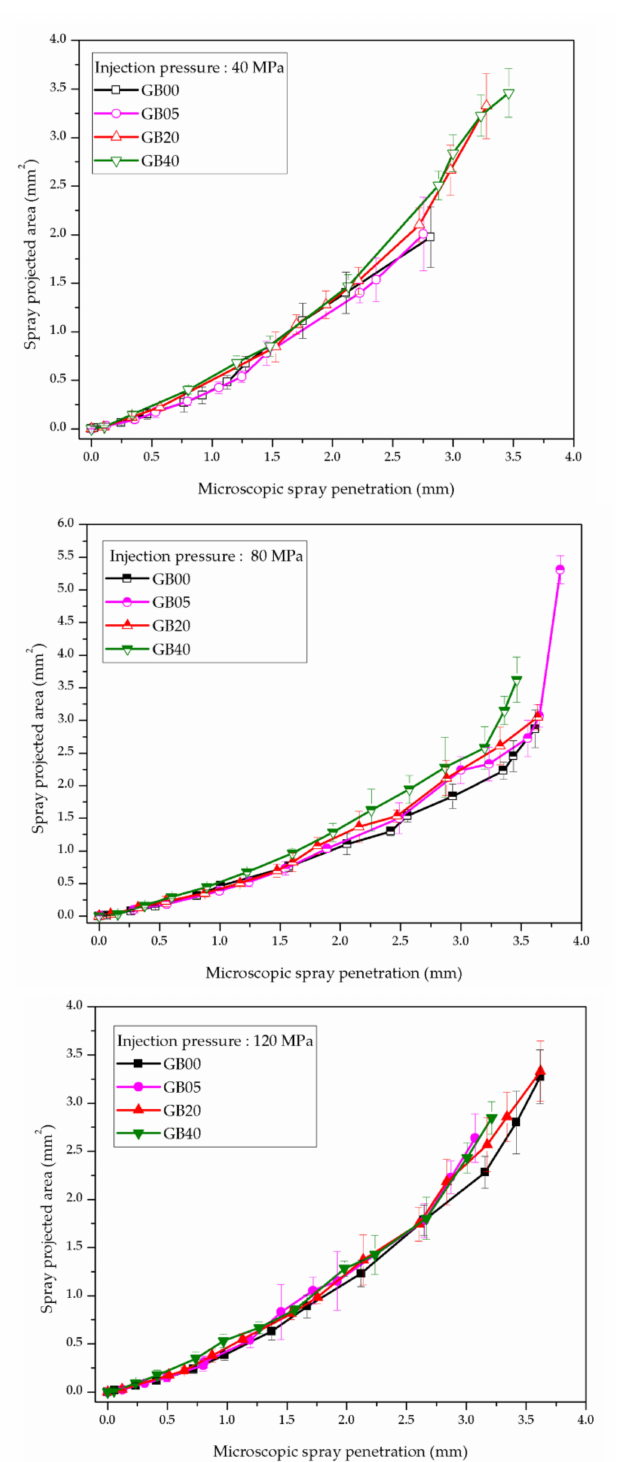
Figure 7. Spray projected areas of GB fuels according to the injection pressure. Top row: 40MPa, Middle row: 80 MPa, Bottom row: 120 MPa (GB00: gasoline 100% and biodiesel 0%, GB05: gasoline 95% and biodiesel 5%, GB20: gasoline 80% and biodiesel 20%, GB40: gasoline 60% and biodiesel